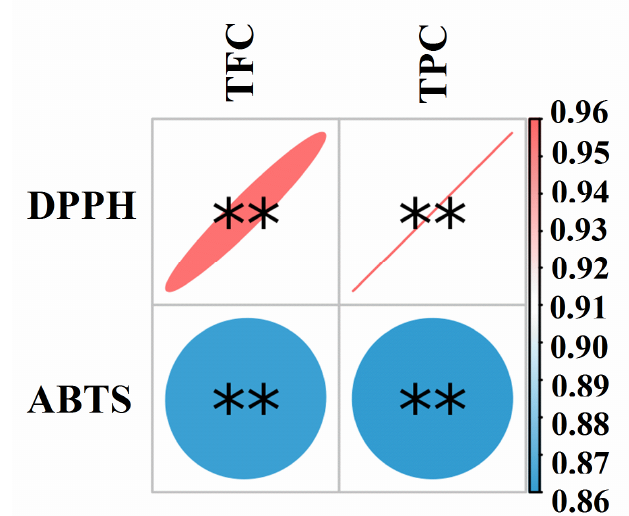
Figure 3. Correlation analyses between total phenolics content (or total flavonoid content) and DPPH radical scavenging activities, ABTS radical scavenging activities of the extracts from water caltrop ( Trapa quadrispinosa Roxb.) husk. TPC and TFC mean total phenolics content and total flavonoid content, respectively. The legend shows the correlation coefficient value; and blue to red represents an increase in correlation coefficient value from 0.86 to 0.96. * marks “index—factor” with significant correlation, ** stands for p < 0.01.